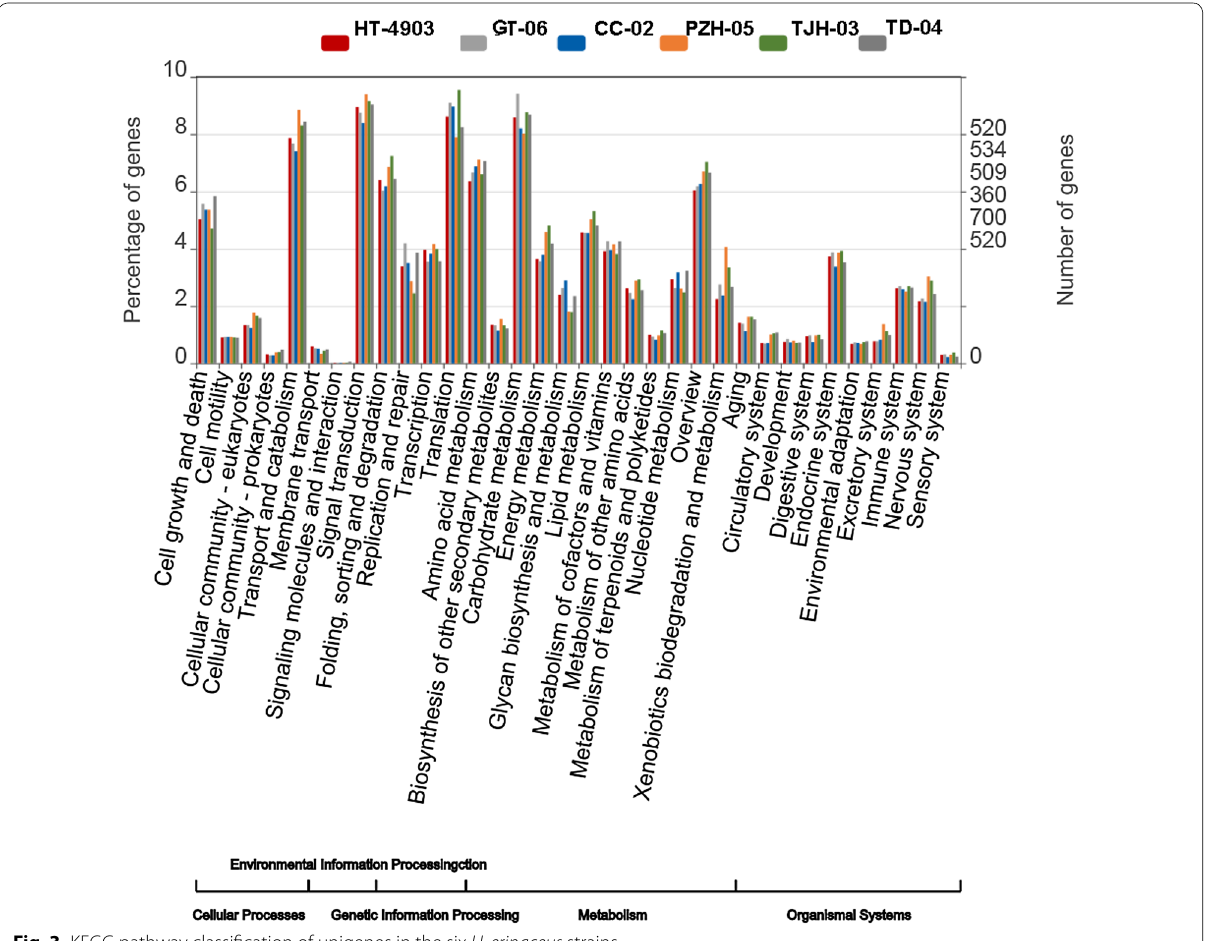
Fig. 3 KEGG pathway classification of unigenes in the six H. erinaceus strains